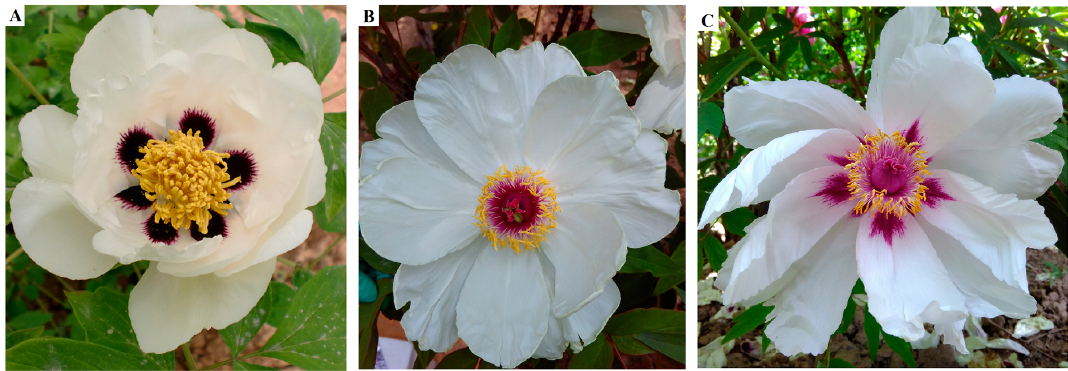
Figure 1. Fully open flowers of individuals selected for sequencing. ( A ) Paeonia rockii ; ( B ) Paeonia ostii ; ( C ) F1 individual derived from crossing between P. rockii and P. ostii .